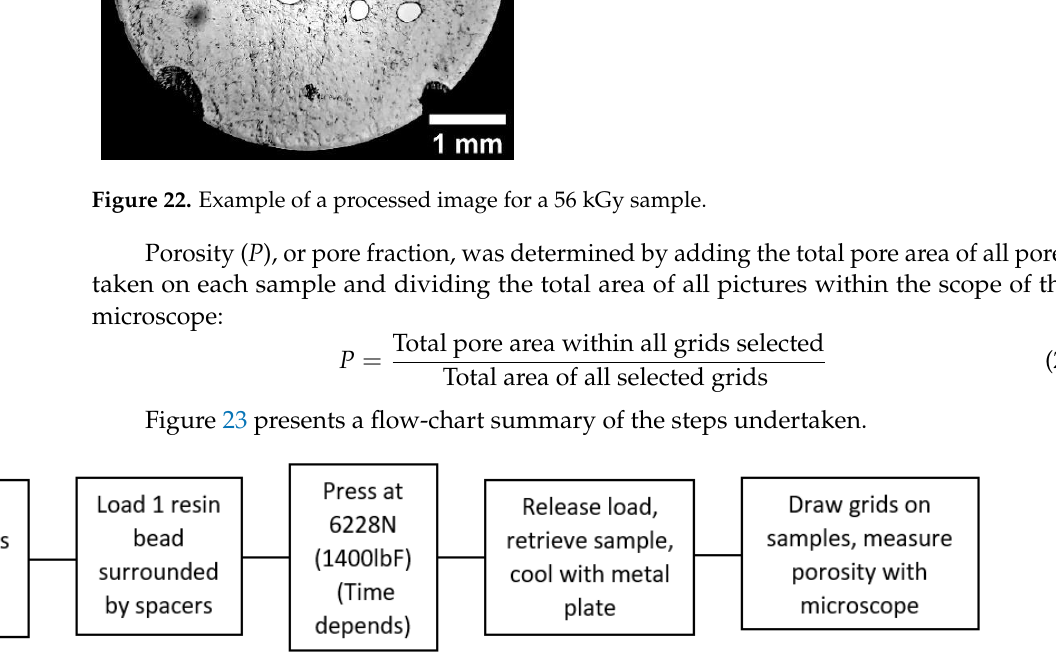
Figure 23. Steps in porosity-related wafer sample production and estimation. Table 6. Experiment test matrix for porosity metric.